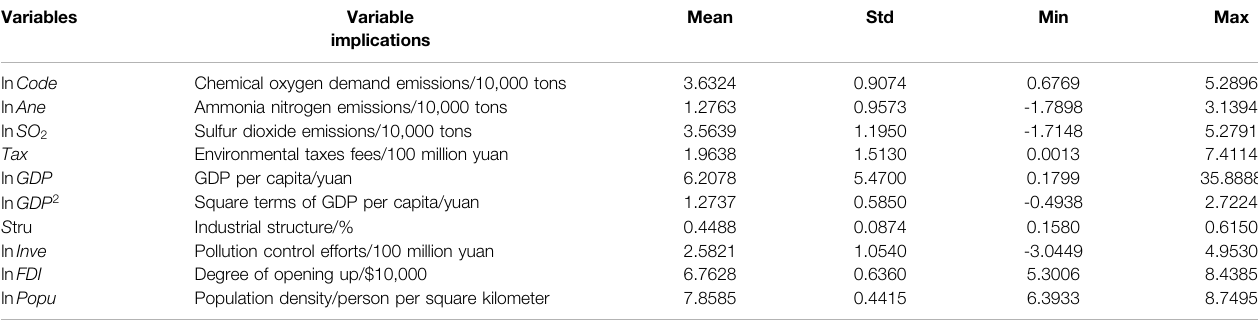
TABLE 1 | Descriptive statistics of variables.